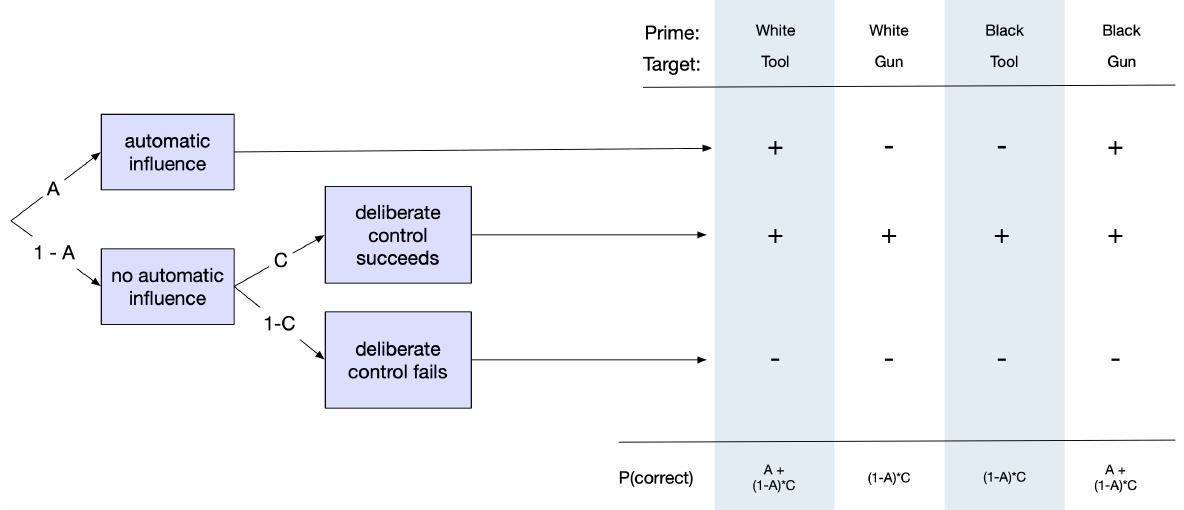
Figure2: Stroop model (automaticity dominant) from Bishara and Payne (2009). Notes: Experimental conditions are shown in columns. Correct responses are indicated with a plus sign (+). Equations for the MPT model are shown at the bottom of each column.